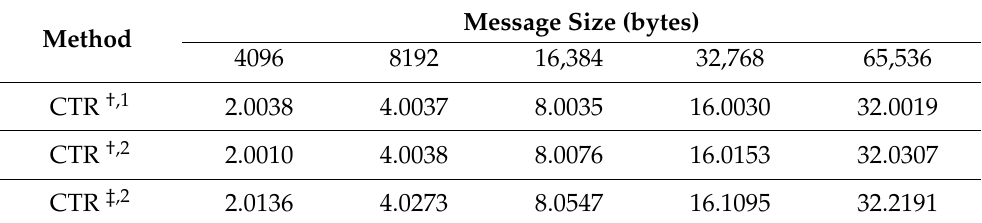
Table 2. Comparison of PRESENT on target embedded processors (AVR) in terms of timing (10 6 clock cycles) depending on message size (bytes), 1 : Pre-computation in RAM, 2 : Pre-computation in ROM,